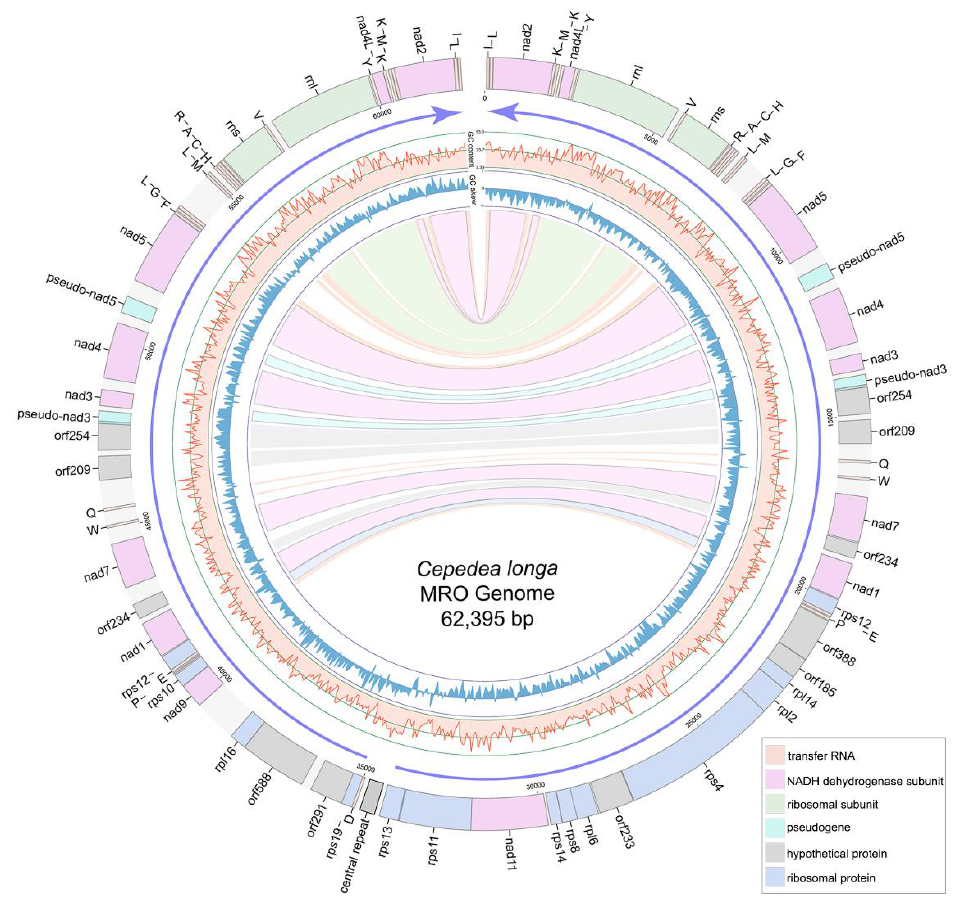
Figure 2. Gene map of the Cepedea longa mitochondrion-related organellar genome. Light blue blocks are ribosomal proteins; pink blocks are nad genes; gray blocks are unidentified ORFs; light orange blocks are tRNA genes; light green blocks are small/large subunit ribosomal RNA genes of MRO genome; grey block with a black box between the tRNA Asp and rps13 genes is the central repeat region of MRO genome. Purple arrows show the transcriptional direction. GC content and GC skew are shown as light red lines and blue lines, respectively. Repeat genes are indicated by corresponding colored links.